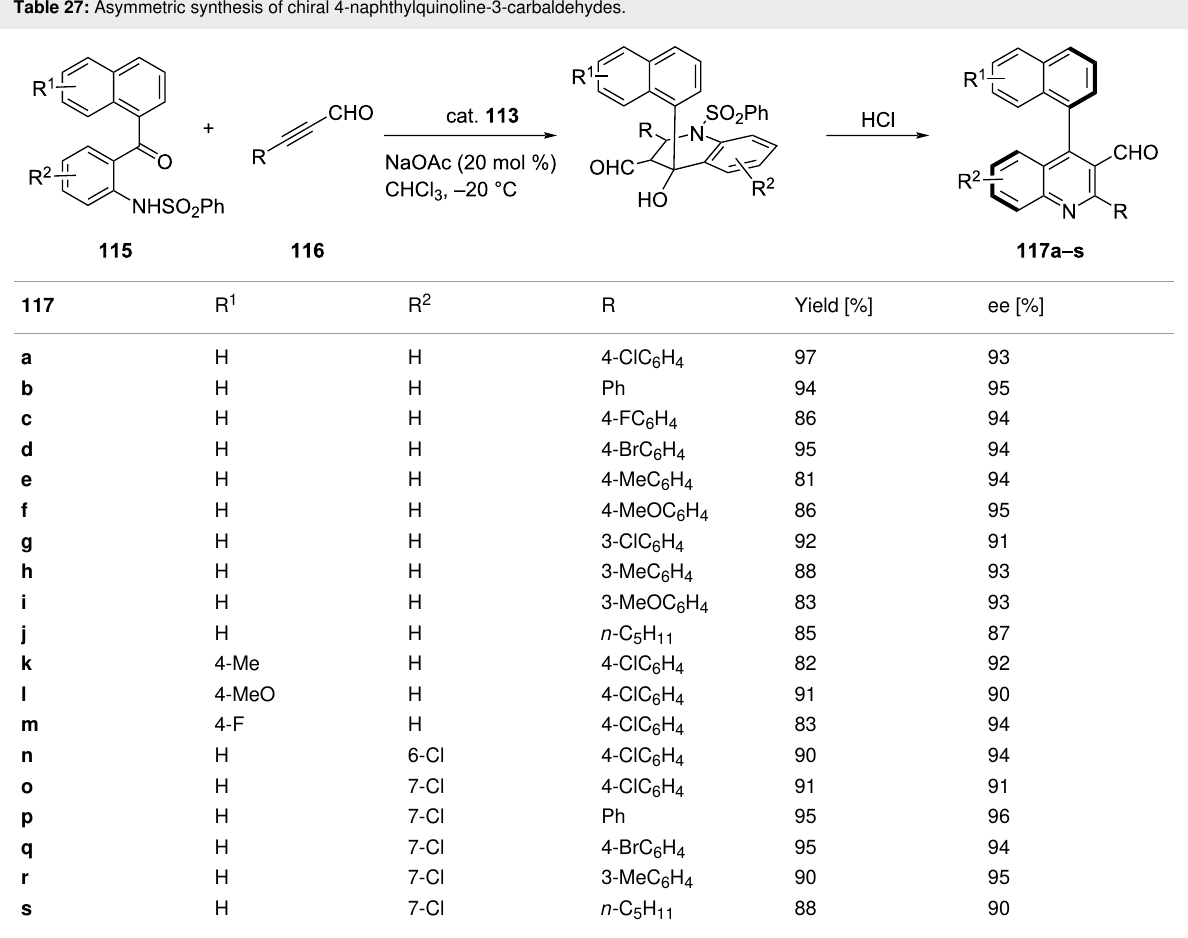
Table 27: Asymmetric synthesis of chiral 4-naphthylquinoline-3-carbaldehydes.